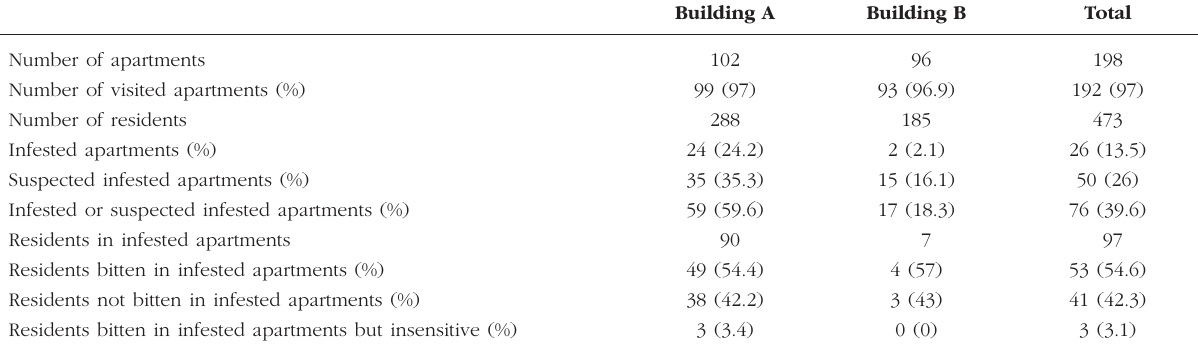
Table I. – Infestation of the two buildings by bed